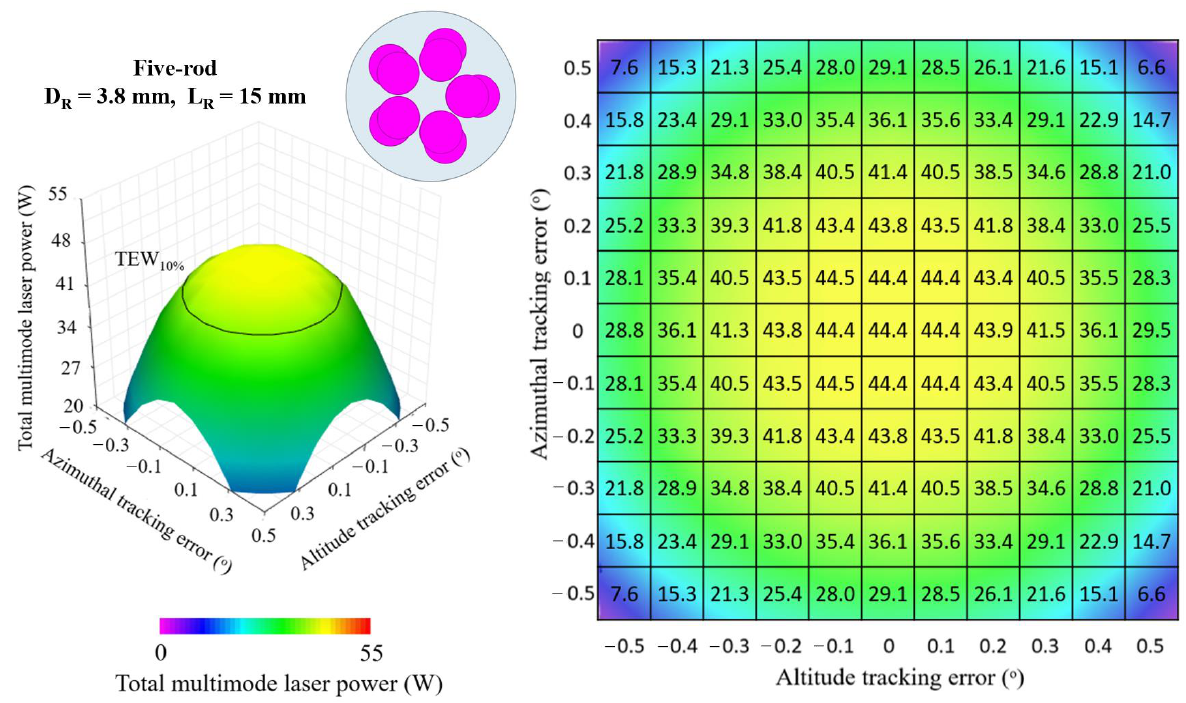
Figure 11. Total multimode solar laser power as a function of the simultaneous tracking error in altitude and azimuthal directions, ranging from the optimal alignment (0.0°) to 0.5°, for the five-rod scheme with D R = 3.80 mm and L R = 15 mm.